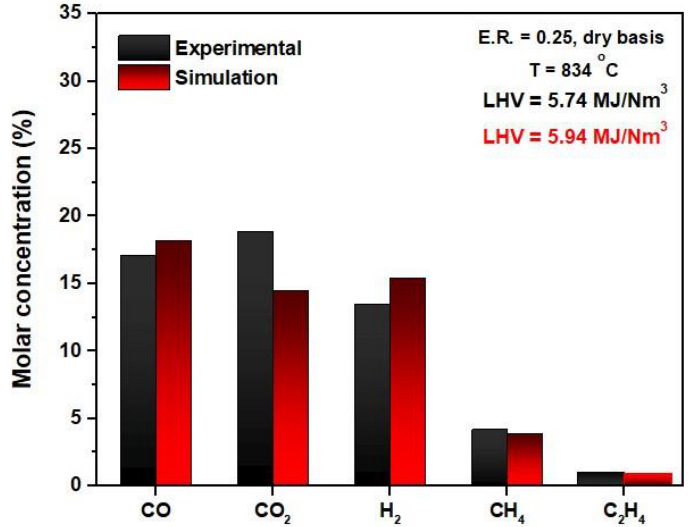
Figure 10. Comparison of the simulation and experimental results at E.R. = 0.25.